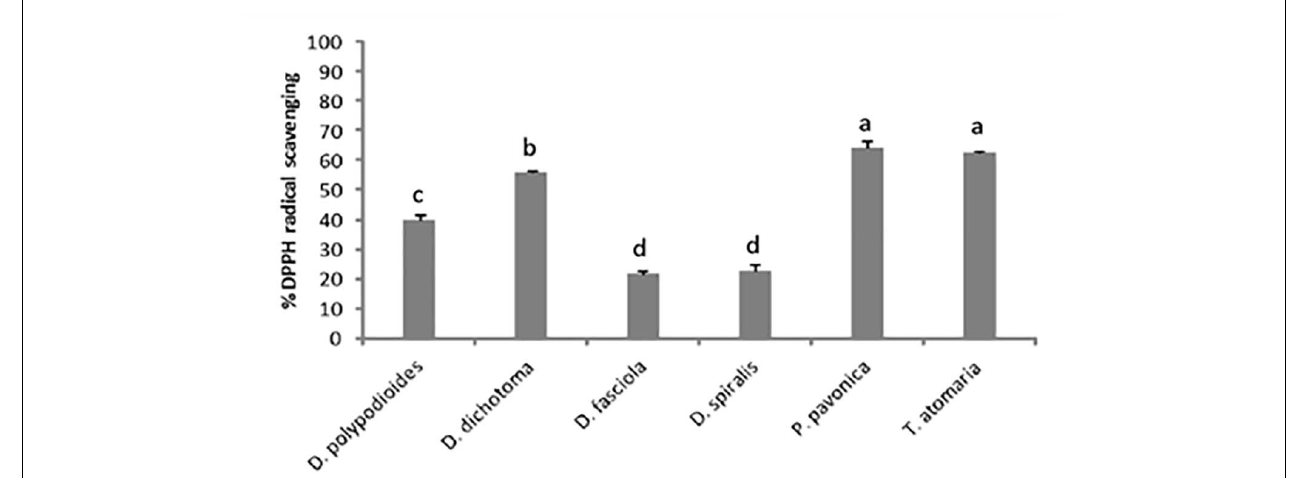
FIGURE 2 | Percentage DPPH radical-scavenging capacity of Dictyotales MeOH extracts at a concentration of 10 mg · ml − 1 .